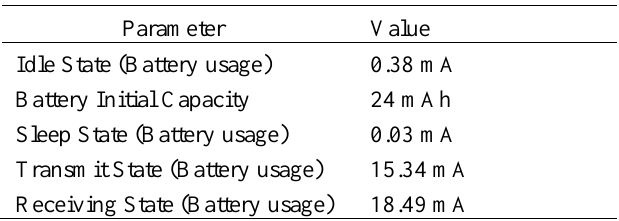
Fig. 4. Comparison between the numbers of allocated devices resulted from the original and enhanced standard 6.2 Total Bytes Received by IEEE 802.15.4